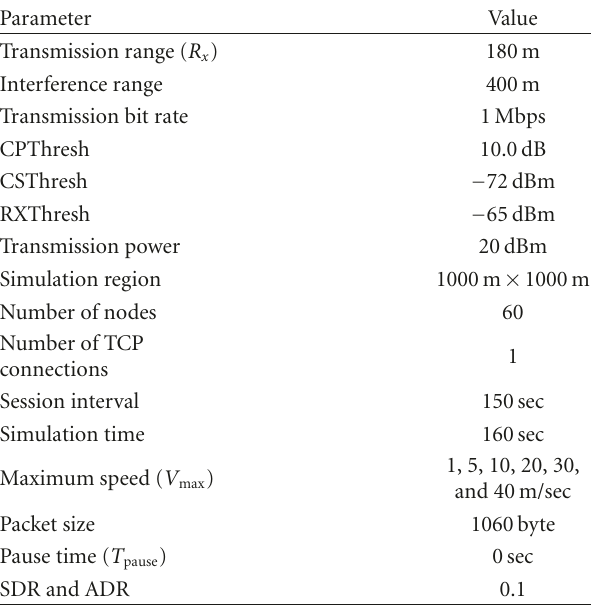
Table 1: Evaluation